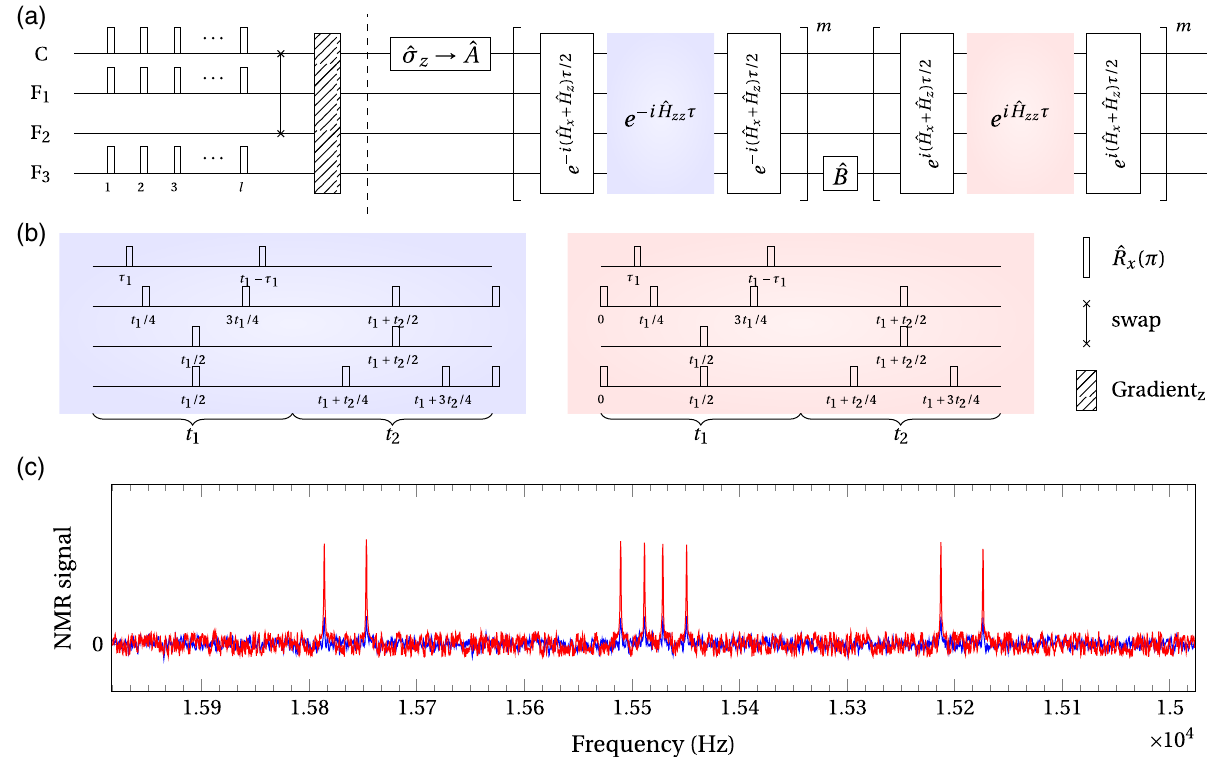
denotes z axis gradient pulse. (b) Sequences for z ˆ R 1 π = 2 Þ . They are y ð